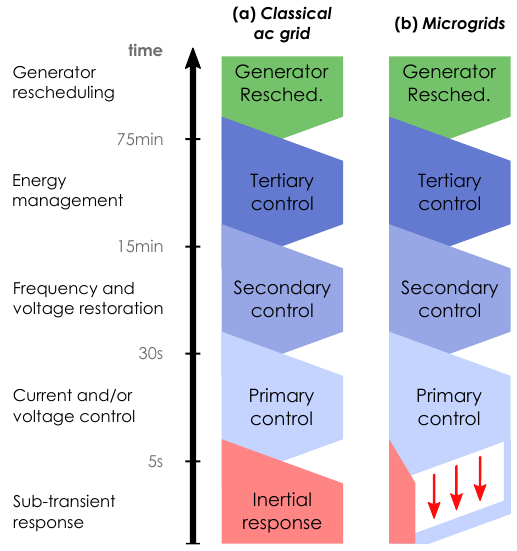
Figure 1. Contribution of different control levels under a power variation ( a ) in the conventional network [11] and ( b ) in